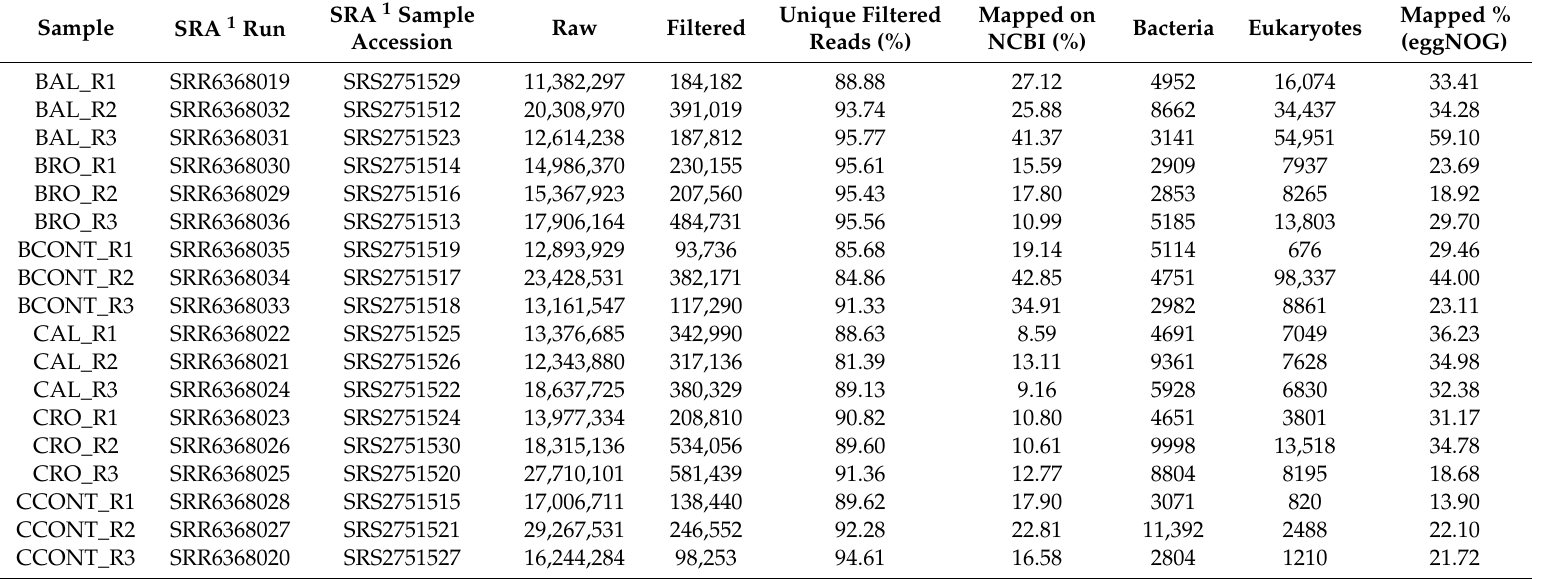
Table 1. Meta-transcriptome reads assignment